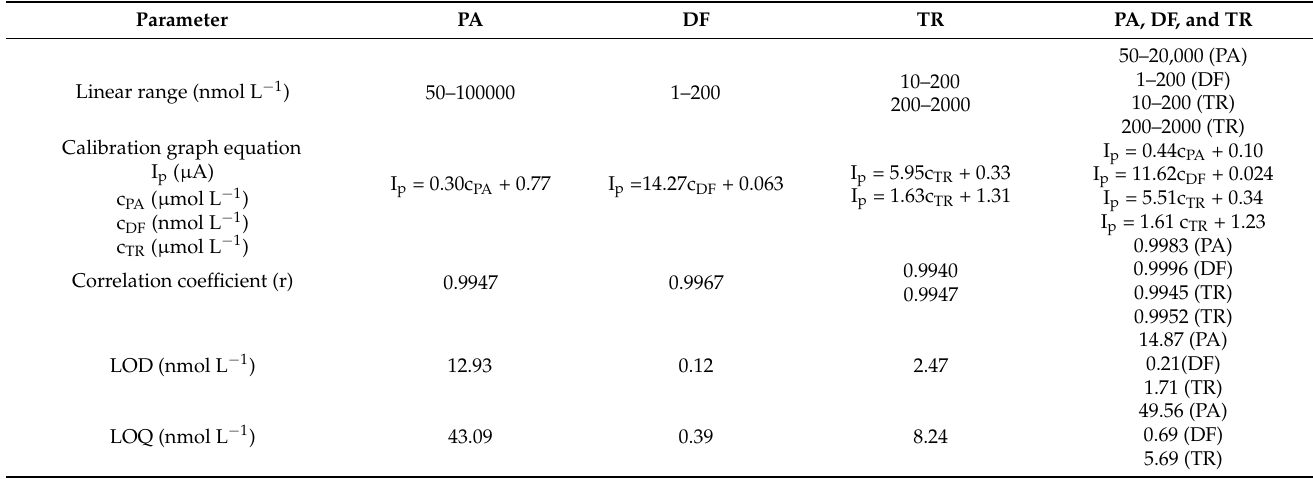
Table 1. Analytical parameters obtained for individual and simultaneous determination of PA, DF, and TR at the aSPCE/SDS. Parameter PA DF TR PA, DF, and TR